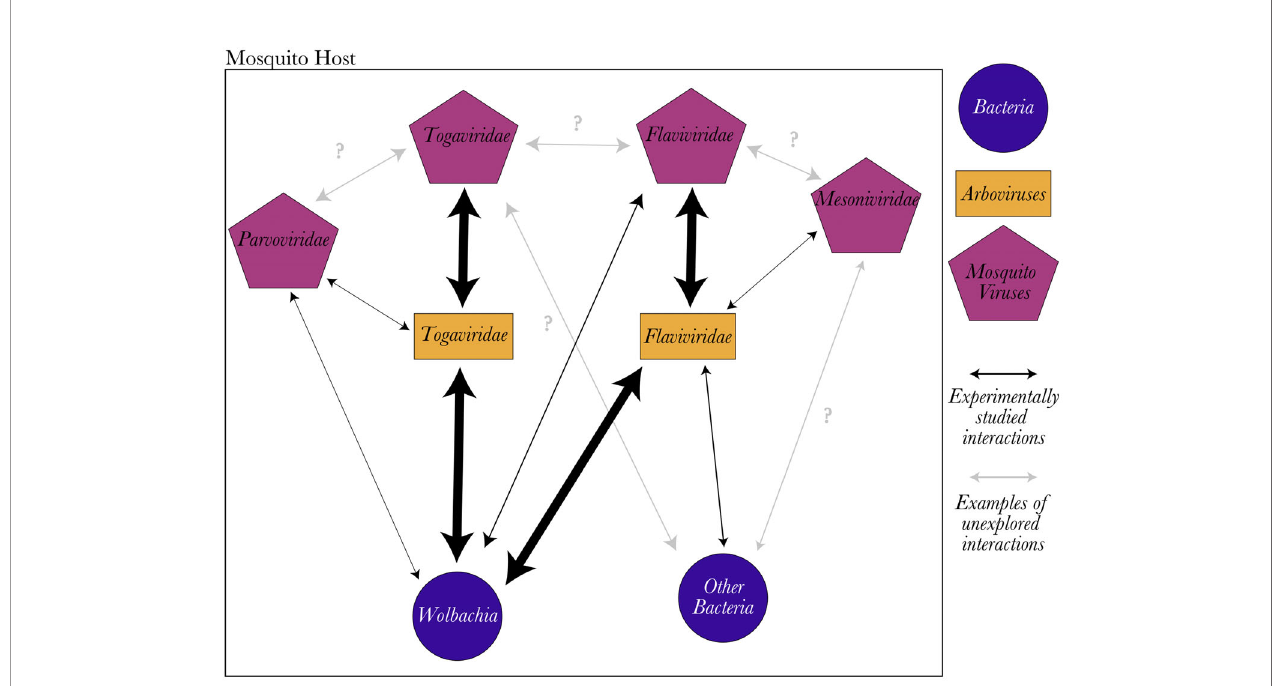
FIGURE 2 | Mosquito virus interactions with the host microbiota. Most experimental studies of microbiota interactions have focused on arbovirus inhibition by bacterial or viral symbionts in important mosquito vectors (represented as wide arrows). However, the rest of the interactions between microbiota and mosquito viruses were poorly studied (represented as thin arrows). Many possible interactions have never been explored experimentally (grey arrows indicate some examples), and additional studies are needed to understand the outcomes of these interactions on mosquito host and host vector competence. Nothing is known about mosquito-virus interactions with each other or the possible mechanisms of these